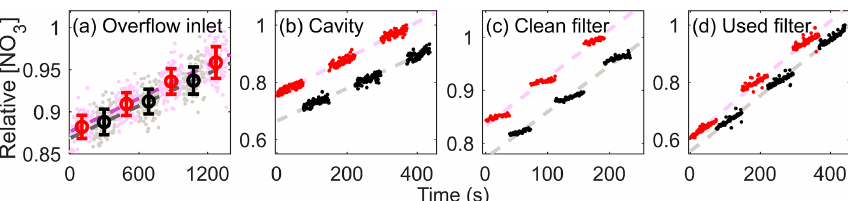
Figure 6. Relative NO 3 concentrations with (black) or without (red) test sections in (a) overflow inlet (averages as circle and 1 σ as error bars), (b) cavity, and (c) clean and (d) used filter (aerosol loading of 12308µg). Light red and gray dashed lines represent concentration drifts inferred from linear interpolation of each condition.